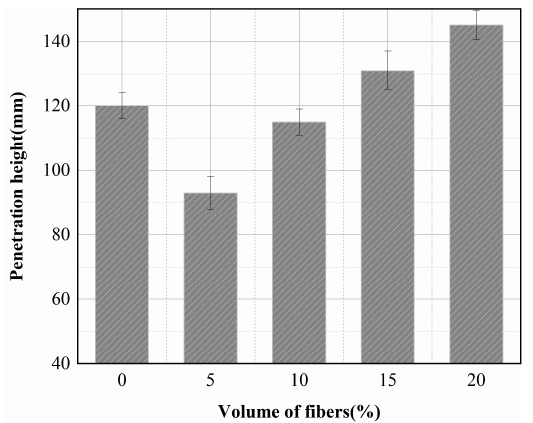
Figure 7. Effect of fiber content on the impermeability of thermal insulation concrete.